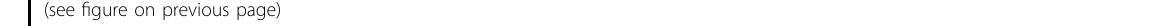
Fig. 3 Inhibitory effects of EHF variants on ZEB1 promoter activity. A and B ZEB1 promoter activities were determined by luciferase assays after transfection with control vector (cont.) or the indicated plasmids. Luciferase activity of cells transfected with the control vector was indicated as “ 1. ” Each value represents the mean ± s.d. of triplicate determinations from a representative experiment. Similar results were obtained in at least three independent experiments. p values were determined by Student ’ s t -test. * p < 0.01; n.s., not signi fi cant. ( C and D ) COS7 cells were transfected with the indicated plasmids, followed by IB ( C ) and RT-qPCR ( D ) to determine the levels of transfected genes. Ectopic EHF-SF mRNA levels of cells transfected with ETS1 alone was indicated as “ 1 ” ( D ). E COS7 cells pre-transfected with fl ag-tagged ETS1 were further transfected with either control vector or fl ag-EHF-SF plasmid, and treated with cycloheximide (CHX) for the indicated time, followed by IB. The ratio of ETS1 to α -tubulin was determined by densitometric analysis and shown at the bottom. ( F and G ) COS7 cells were transfected with the indicated plasmids followed by immuno fl uorescence analysis using an anti- fl ag antibody. Arrow indicates cells with low expression of fl ag-EHF-LF. H Subcellular localization of endogenous EHF was determined by anti-EHF antibody in HNSCC OTC04 and SAS cells. High magni fi cation is shown in bottom